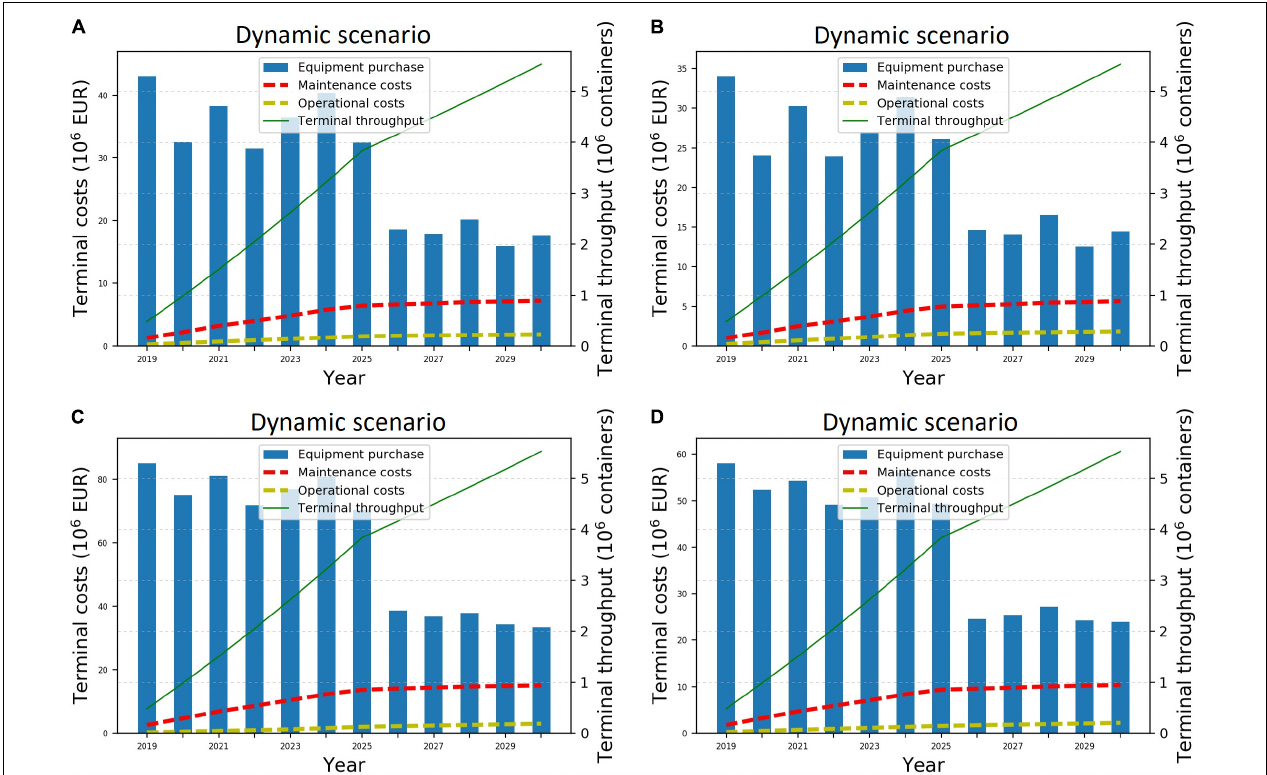
FIGURE 6 | Total terminal costs, dynamic scenario, cases ( A–D